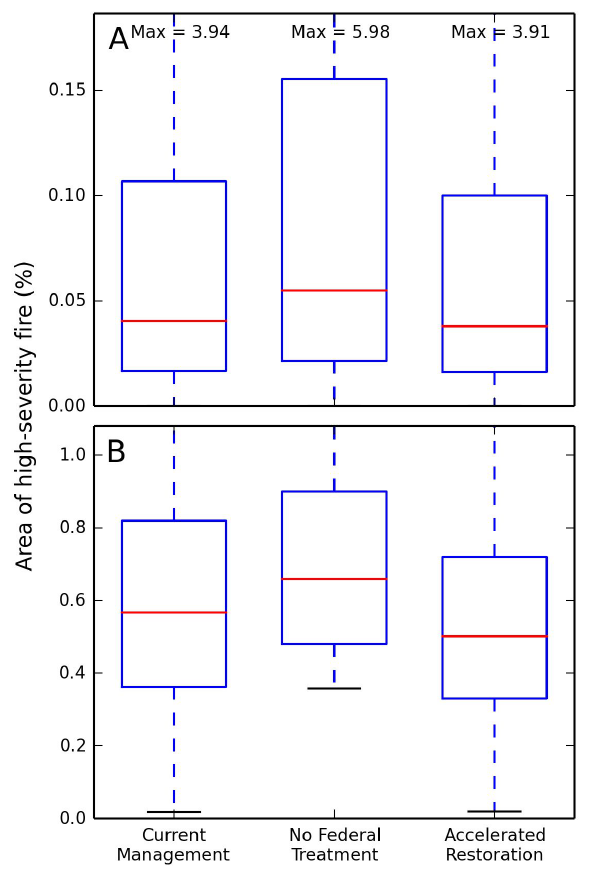
Fig. 4. Box and whisker plots of area of high-severity fire (%) for different management scenarios. Annual areal proportion of stand-replacing wildfire in all fire years for fire-prone potential vegetation types and all ownerships (A), and the top 10% of fire years ( N = 75 of 750 replication years) in terms of area